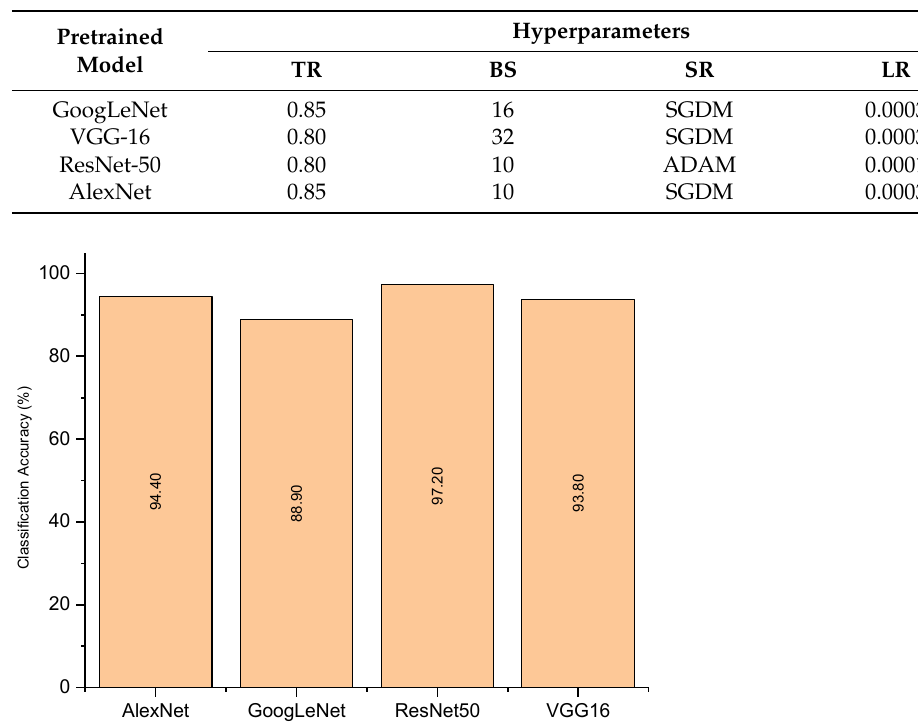
Table 2. Best hyperparameters for the pretrained models.